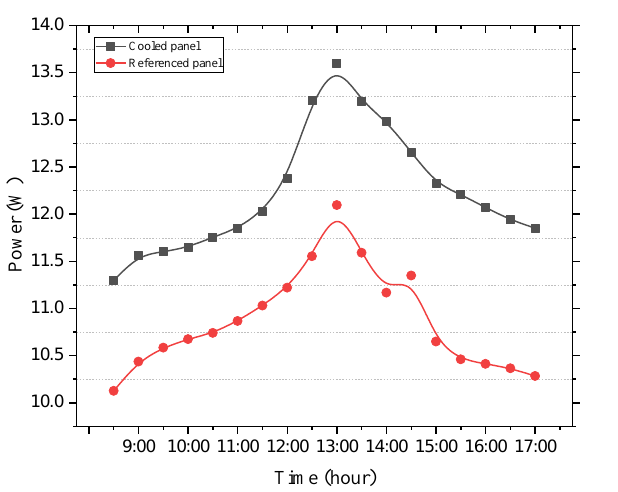
Figure 10. Output power for both panels.